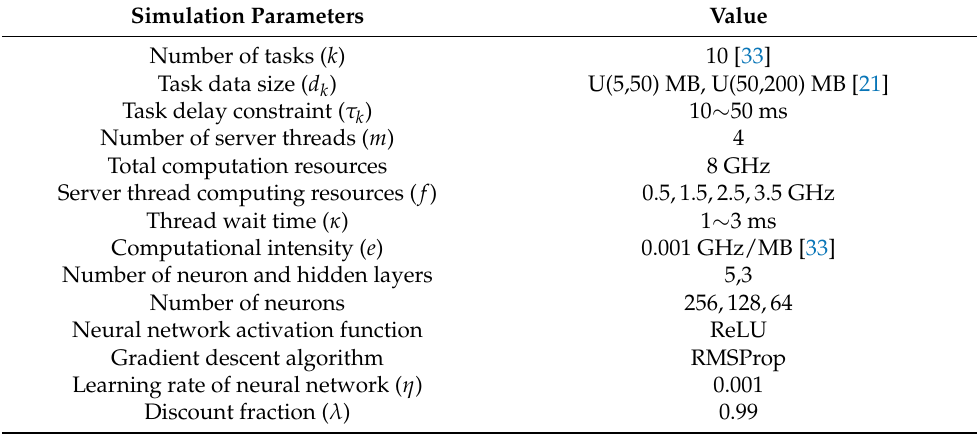
Table 1. Simulation parameters.